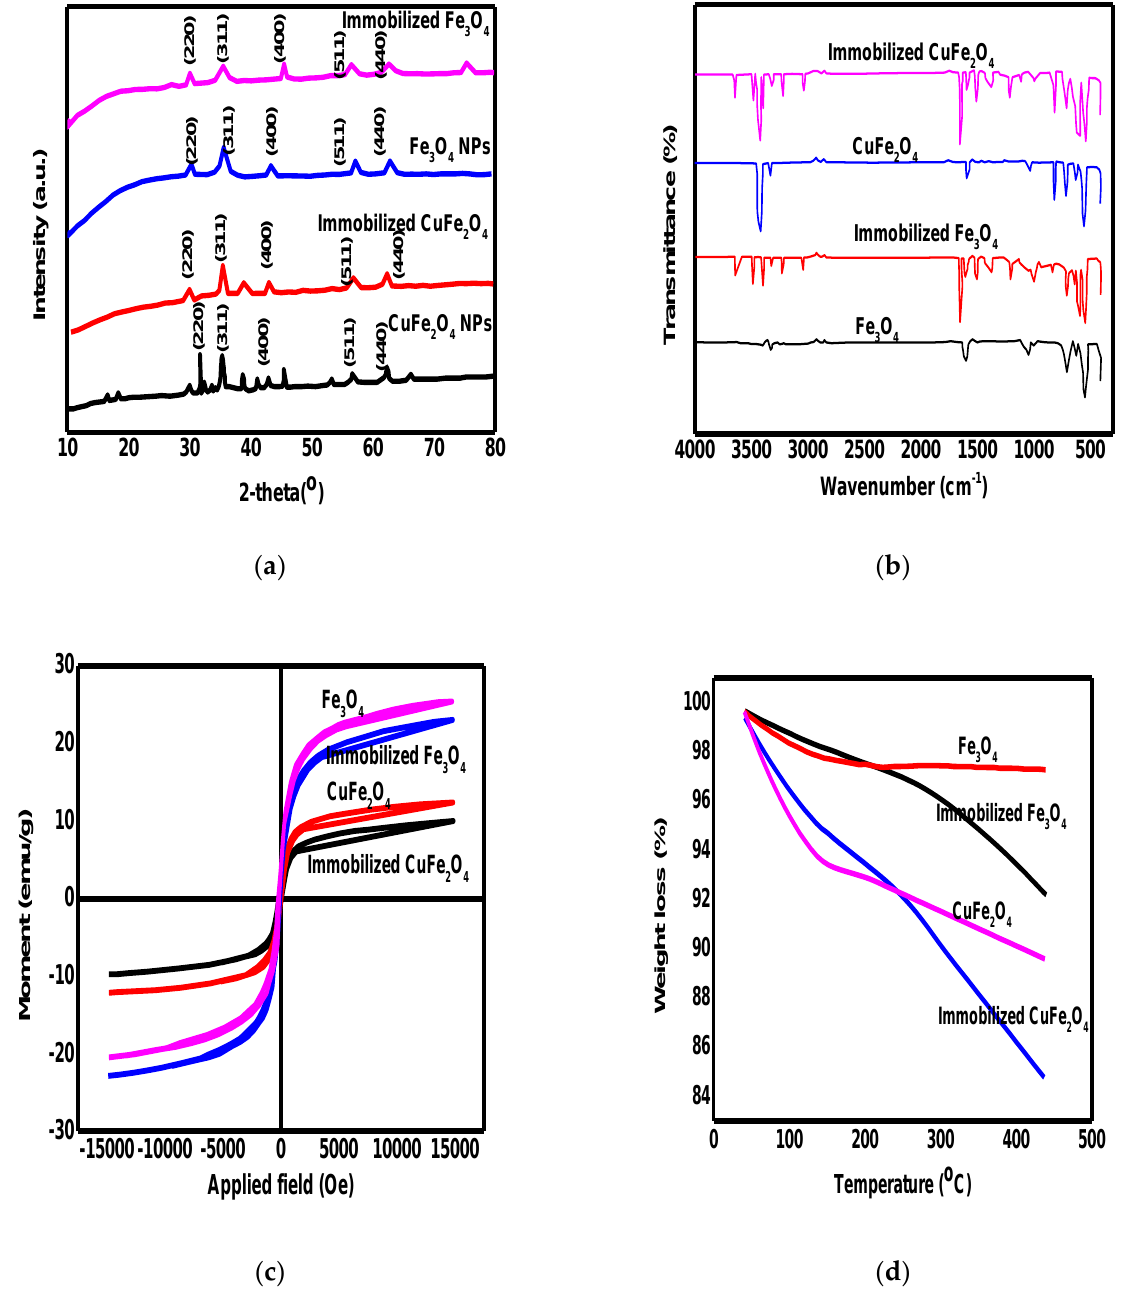
Figure 1. XRD ( a ), FT-IR ( b ), TGA curves ( c ), and magnetization curves ( d ) of synthesized Fe 3 O 4 nanoparticles, CuFe 2 O 4 nanoparticles, and nanoparticle-immobilized laccase.